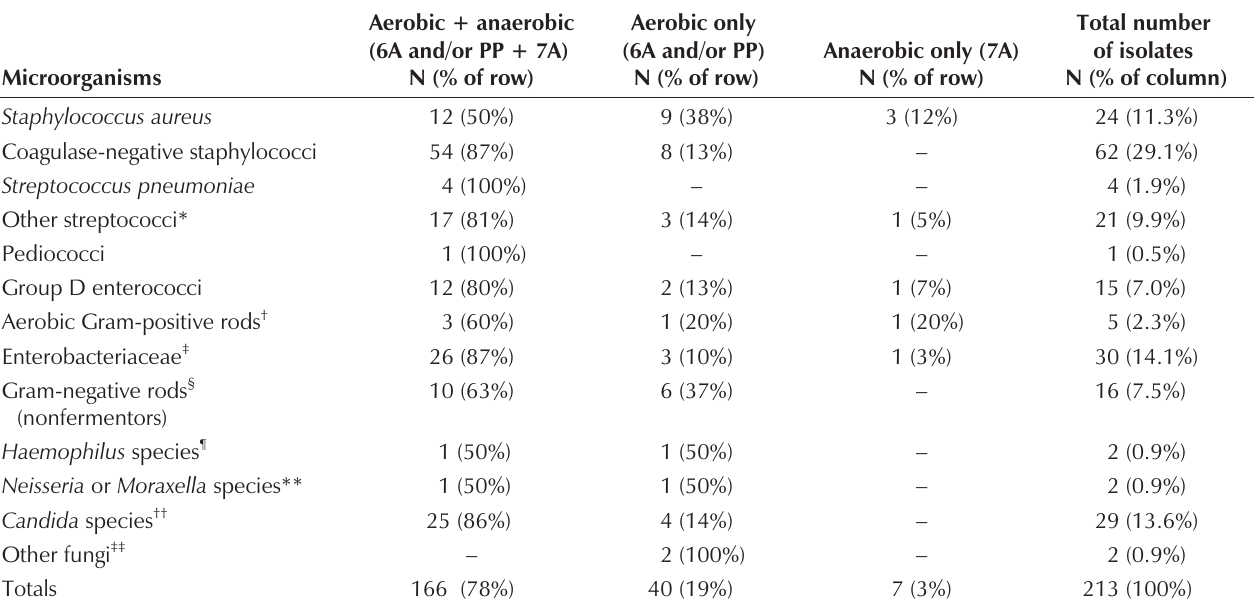
TABLE 2 Recovery of clinically significant isolates in aerobic and/or anaerobic medium from hospitalized children